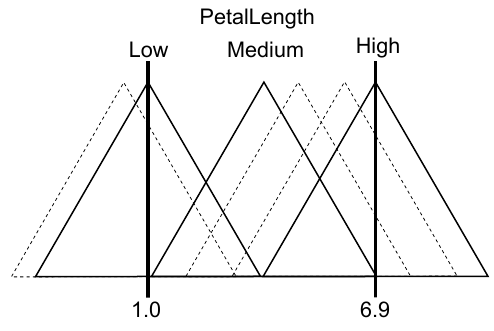
Fig. 2. Initial and lateral tuning for the variable